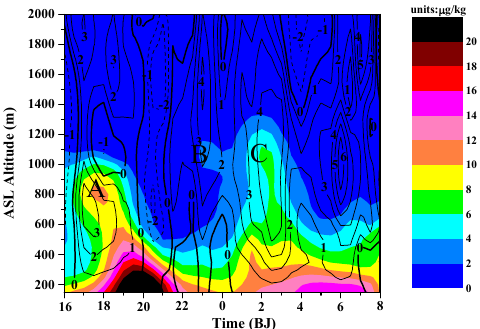
Figure 15. Time-altitude diagram of the simulated BC concentration (shading, unit: µ g / kg) and vertical velocity (black contours. Solid contour lines represent positive values, and dashed contour lines represent negative values, unit: cm / s.) over Daqing from the evening of 24 October to the morning of 25